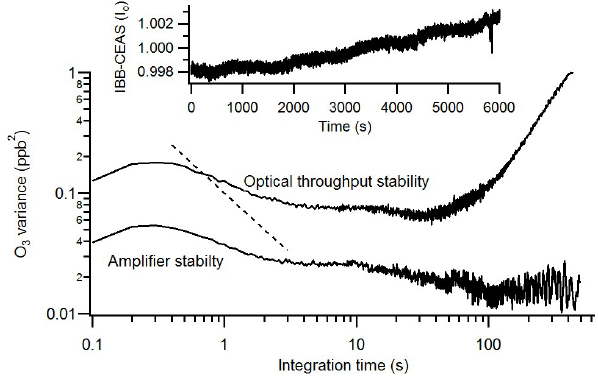
Figure 6. Allan variance analysis to determine improvement gains from data averaging, and the time domain for re-zeroing of the background to attain a targeted precision. Dashed line represents theoretical white noise. Roll off at 0.1-0.4 seconds integration is related to amplifier bandwidth limit.